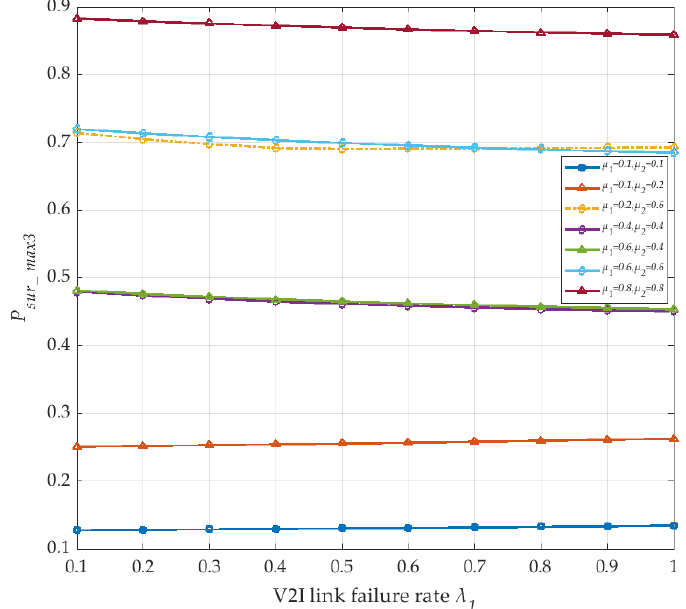
Figure 8. The maximum survival probability of the V2I network with link failure rate λ 1 (corresponding to μ 1 and μ 2 ).